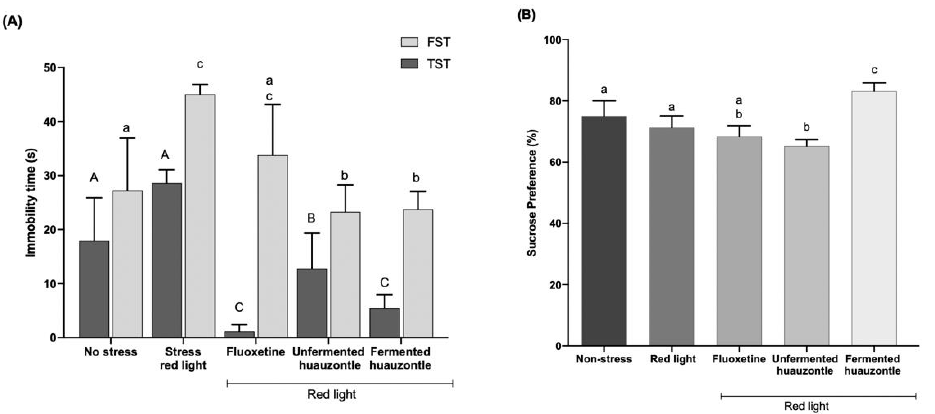
Figure 3. Effect of huauzontle on depressive-like behaviour. ( A ) Immobility time for FST and TST test; ( B ) Sucrose preference (%). Data are expressed as mean ± SEM (n = 5), p < 0.05. Capital letters indicate statistical difference for immobility time for TST test, and lowercase letters denote difference for the FST test and sucrose preference.